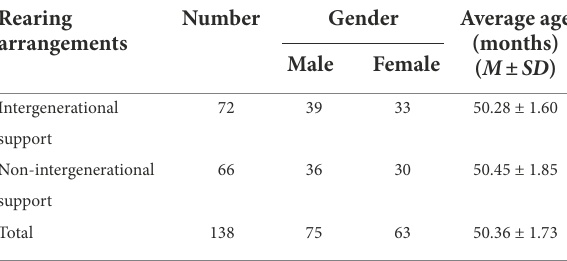
TABLE 1 The distribution and the average age of the children according to different rearing arrangements. Rearing